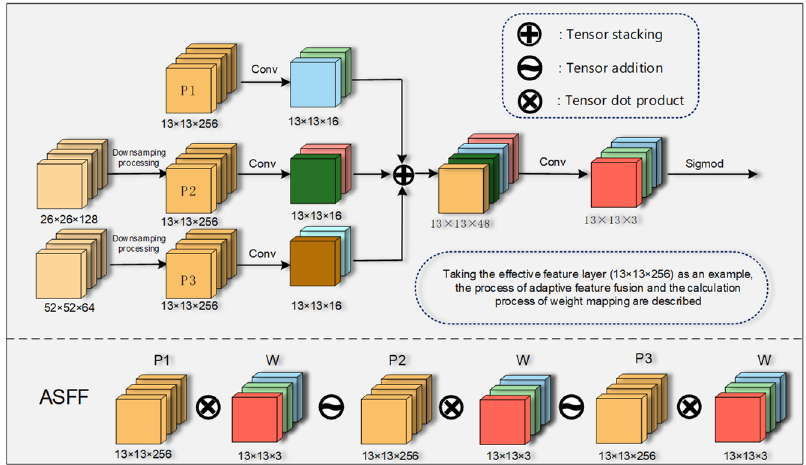
Figure 9. ASFF network structure.